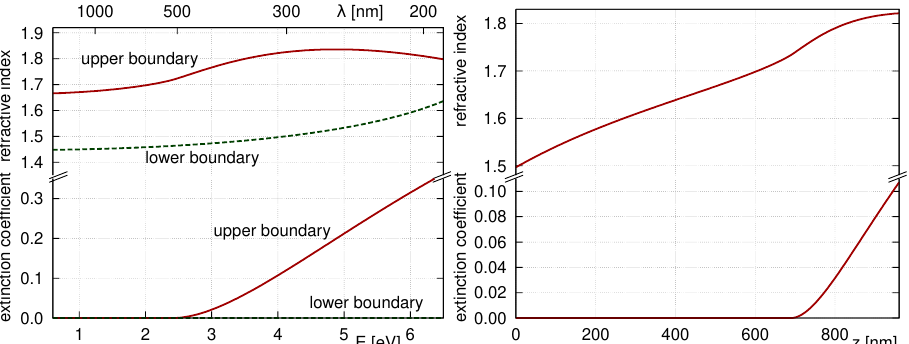
Figure 5. The spectral dependencies ( left ) and the depth profile at E = 4eV ( right ) of the optical constants of the inhomogeneous layer SiO x C y H z thin film.